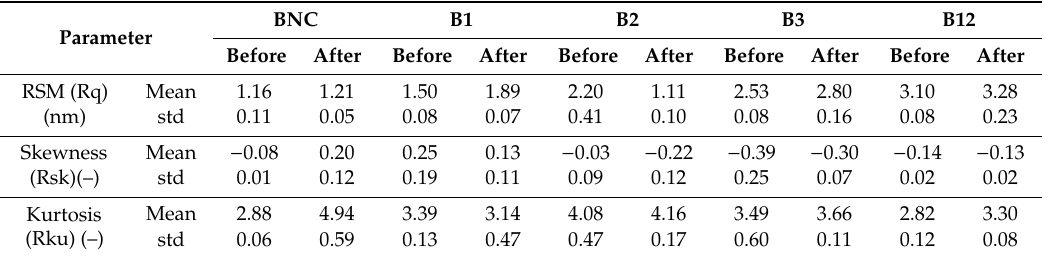
Table 2. Roughness parameters obtained by atomic force microscopy (AFM) analysis of BNC and B complex vitamins